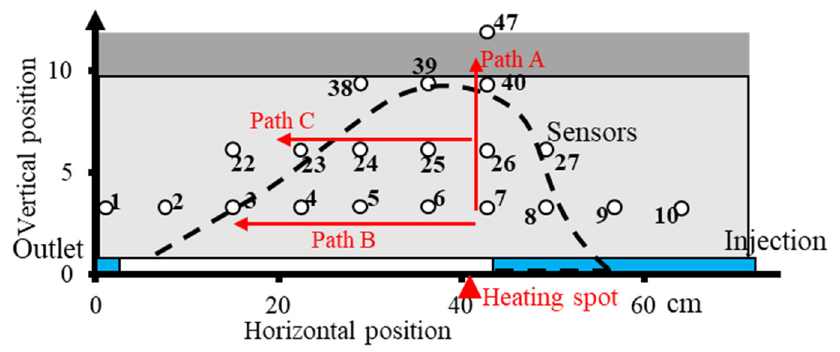
Figure 5. Temperature monitor layout in coal seam (Lower temperature points 1–10, middle tem- perature points 22–27, top temperature points 38–40 and roof plate temperature point 47 are set for monitoring the first gasification chamber).